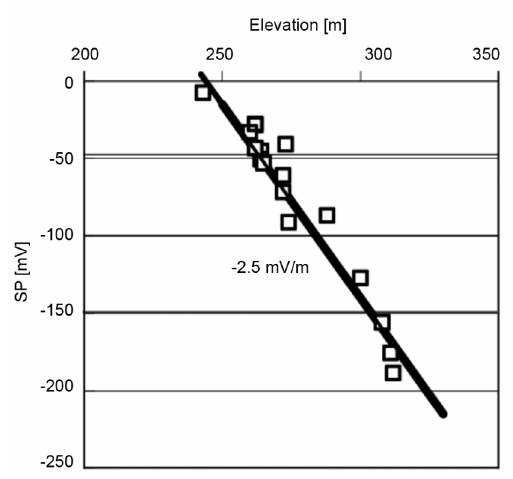
Fig. 7. SP values within a dashed ellipsoid in fig. 6a are plotted against ground elevation along the NW slope of Nishiyama. A regression line is also